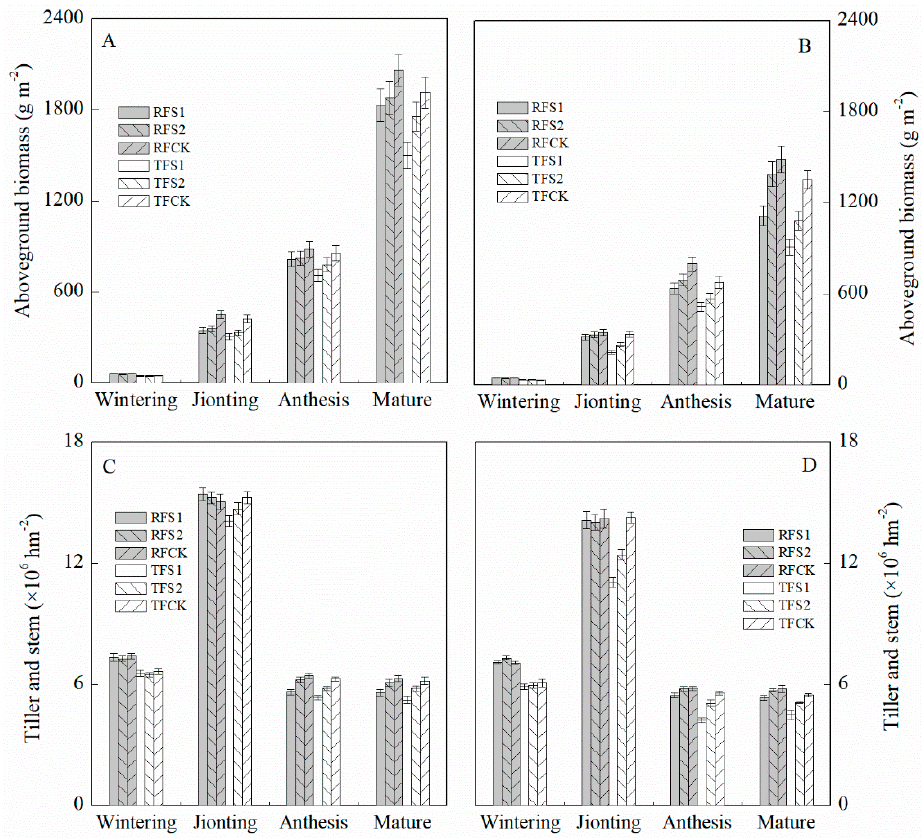
Figure 4. Effects of planting and irrigation on the aboveground biomass (( A ): 2016–2017, ( B ): 2017– 2018) and the tiller and stem number (( C ): 2016–2017, ( D ): 2017–2018) during the wheat growth period. RF: plastic-covered ridge and furrow planting; TF: traditional flatten planting; S1: supplemental irrigation based on measuring soil moisture and the target relative soil water content is 85%; S2: supplemental irrigation based on measuring soil moisture and the target relative soil water content is 100%; CK: traditional irrigation. Vertical bars represent ± the standard deviation of the mean ( n = 3).